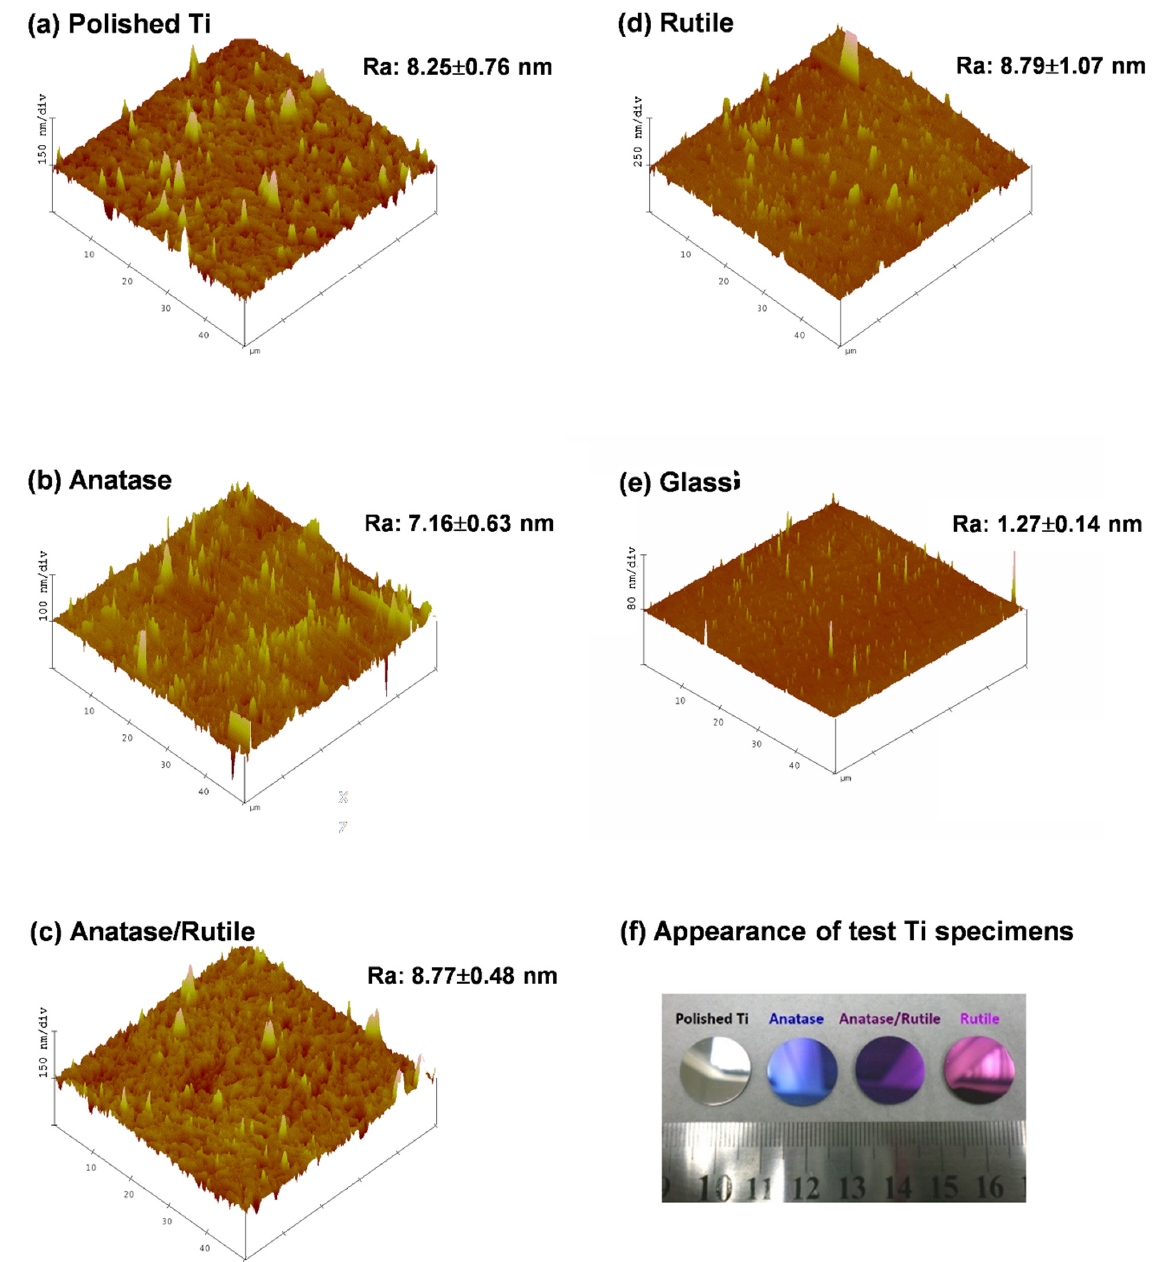
Figure 1. Surface topography of the test specimens, analysed via AFM: ( a ) T group (non-crystalline polished Ti surface), ( b ) A group (TiO 2 anatase phase), ( c ) R group (TiO 2 rutile phase), ( d ) AR group (mixed anatase/rutile phase), ( e ) G group (silica glass); ( f ) visual appearance of test Ti specimens. All test Ti groups (T, A, AR, and R) showed similar and small surface roughness values (Ra—8 nm) and mirror-like